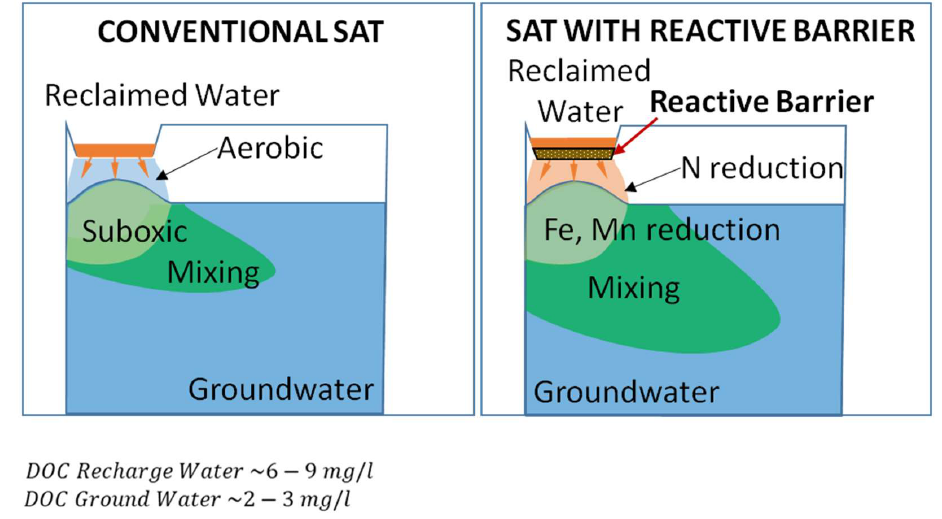
Figure 1. Schematic description of redox zonation during infiltration without and with a reactive barrier. The barrier adds dissolved organic carbon (DOC) to the recharge water, thus promoting highly reducing conditions. Ideally, the vadose zone becomes aerobic during drying periods in both cases.